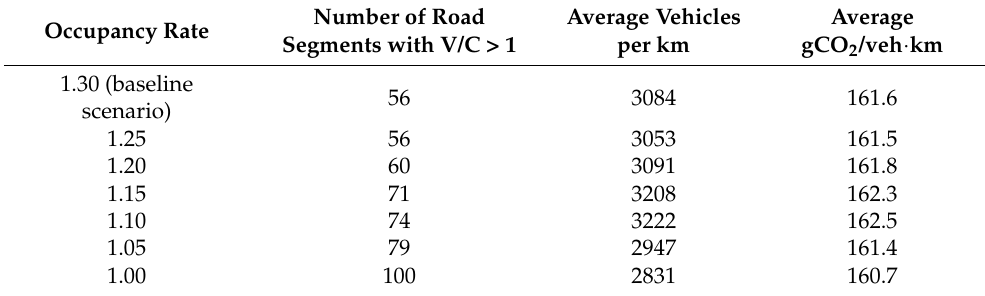
Table 4. Network conditions for scenario (2).